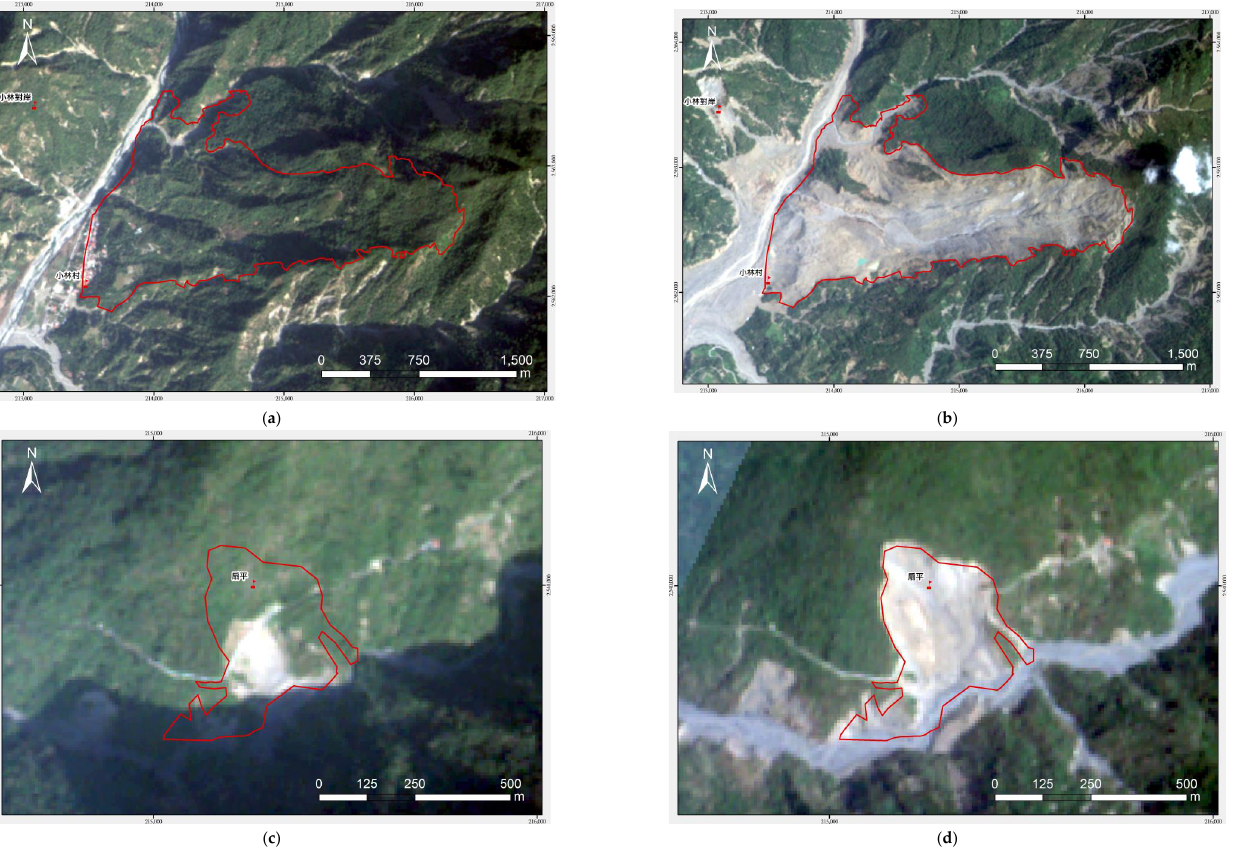
Figure 1. Landslide types of satellite images: newborn landslide ( a , b ) and expanded landslide ( c , d ). (modified from: [66]). ( a ) Xiaolin Village Landslide (pre-event), ( b ) Xiaolin Village Landslide (post-event), ( c ) Shanping Landslide (pre-event), ( d ) Shanping Landslide